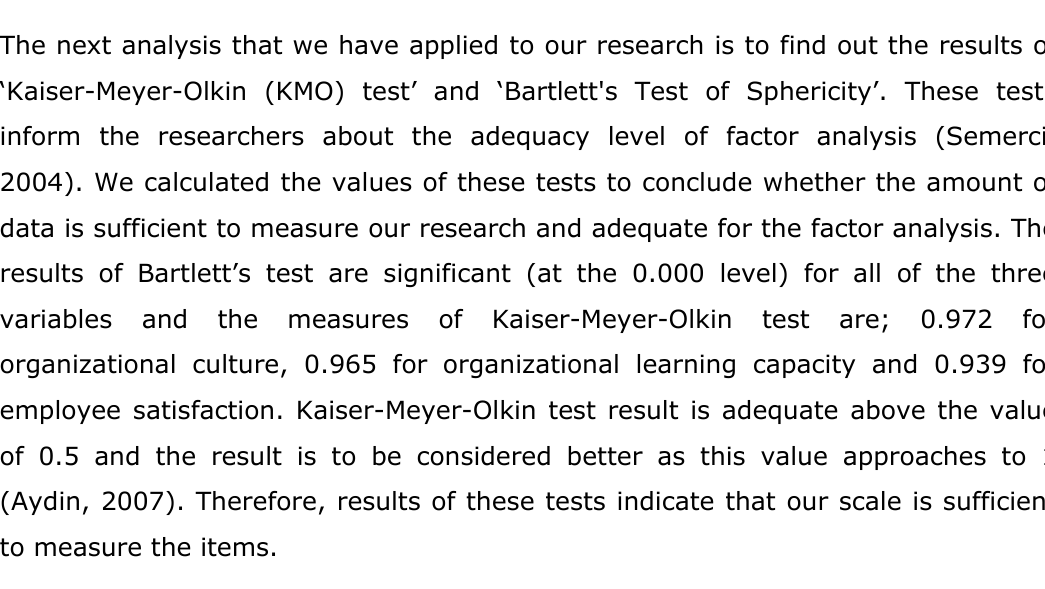
Table 3. “Factor Analysis (Component Matrix / Employee Satisfaction)”. (Extraction Method: Principal Component Analysis. 1 component